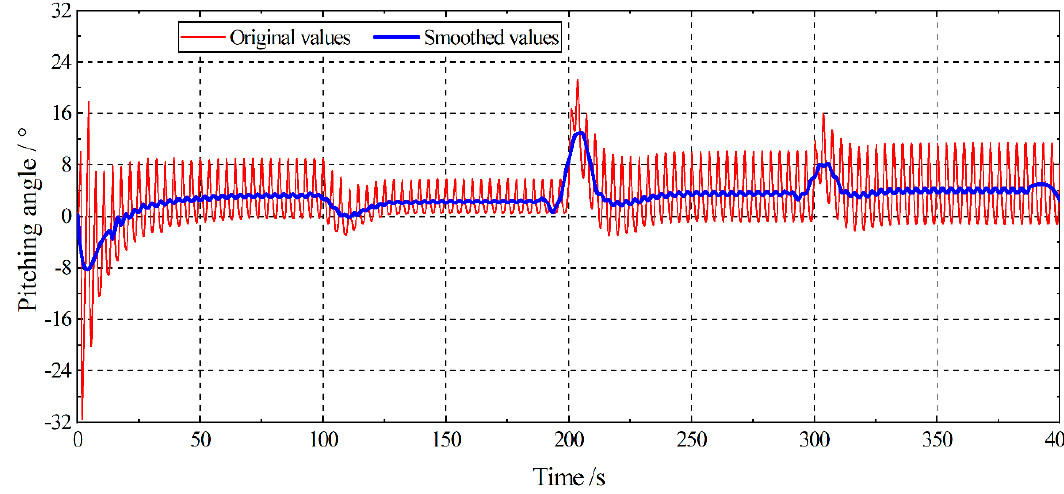
Figure 16. Time history of pitching angle of the towed vehicle.